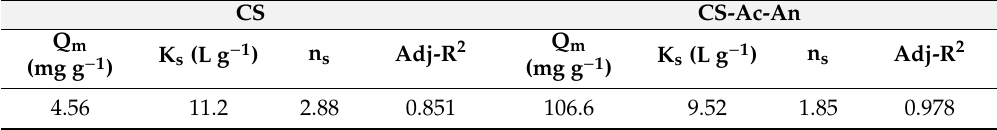
Table 1. Sips model adsorption parameters for Cu(II) uptake with CS and CS-Ac-An at 23 ◦ C. CS